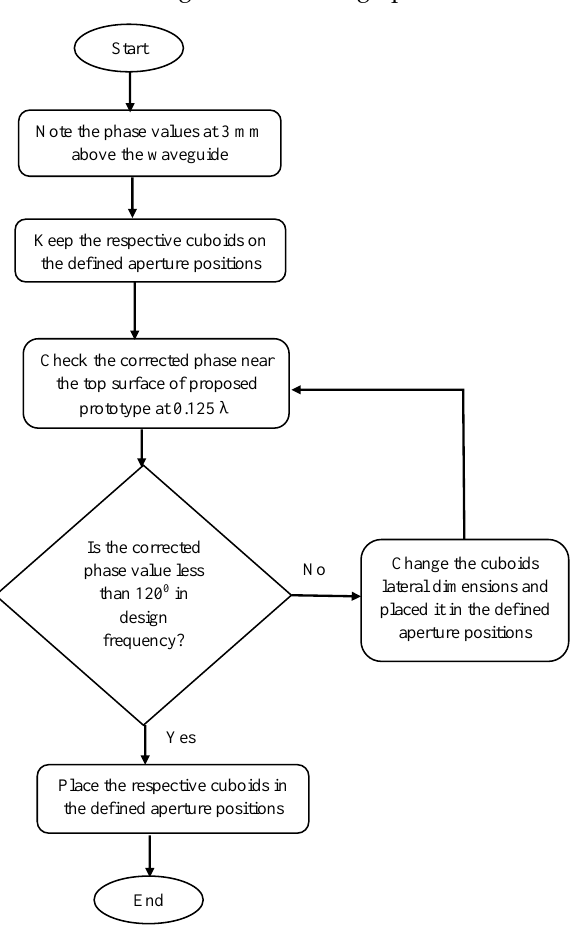
Figure 3. Flow diagram showing the generation of the proposed prototype. Thus, the noted phases were normalized considering the phase value as greater than the maximum, which would ultimately determine the respective cuboids that shall be placed at the respective distances of 3.75 mm, 11.25 mm, 18.75 mm, and 26.25 mm from the center of the aperture. From the data, as shown in Figure 1b, the respective phase values determined the corresponding cuboids’ lateral dimensions, which were 7.5 mm, 7 mm, 4.5 mm, and 4 mm, and were placed at the respective positions of 3.75 mm, 11.25 mm, 18.75 mm, and 26.25 mm from the center of the aperture. Successively, we slightly tuned the cuboids’ lateral dimension around the aperture, which was at a distance of 26.25 mm from the center, where its value decreased to 3 mm, and the overall height of the cuboids was maintained at 8.83 mm, as well as the cavity height at 16.5 mm. This was performed to obtain a higher directivity and gain of the antenna system, which shall ultimately generate a more uniform phase above the proposed metasurface. Hence, we had four different rounds of cuboid placement. Round 1, Round 2, Round 3, and Round 4 were considered respectively for 3.75 mm, 11.25 mm, 18.75 mm, and 26.25 mm from the center of the aperture. The obtained proposed metasurface is shown in Figure 4a,b, respectively the top and perspective